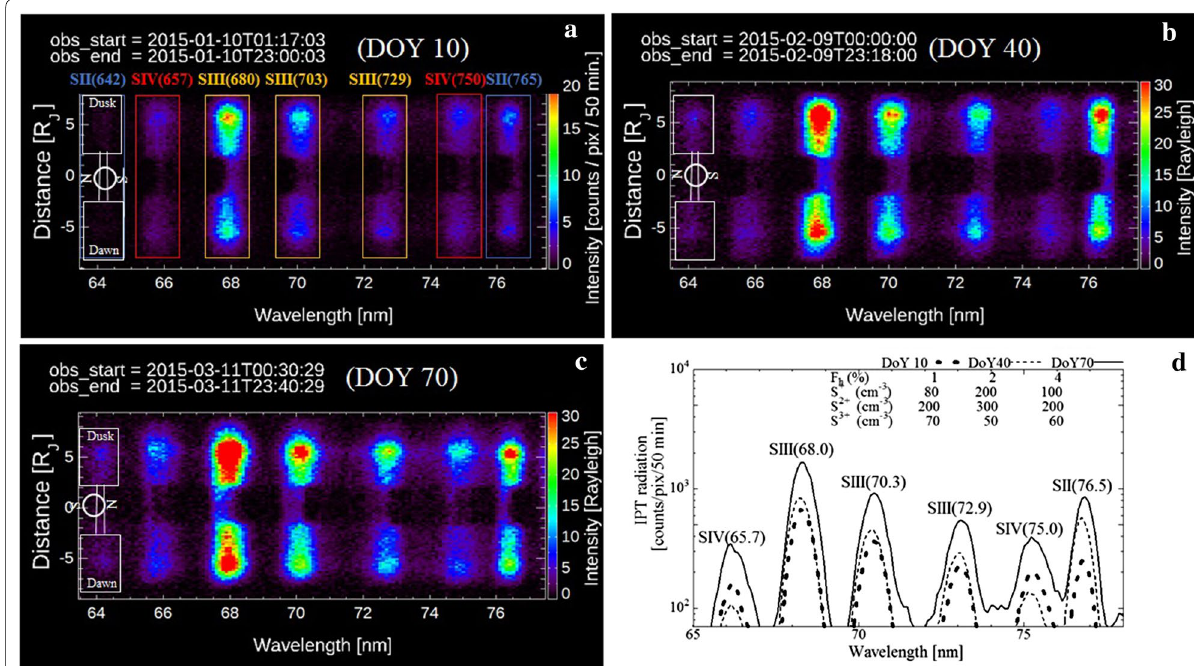
Fig. 4 a Spectrum in the short EUV range (65–78 nm) obtained on day-of-year (DOY) 10 in 2015 (before the eruption). Emissions from ionized sulfur occurred at S II (64.2 nm), S IV (65.7 nm), S III (68.0 nm), S III (70.3 nm), S III (72. 9 nm), S IV (75.0 nm), and S II (76.5 nm). The slit shape and directions (dawn–dusk and north–south) are displayed. b Spectrum on DOY 40 (rising phase of the eruption). c Spectrum on DOY 70 (peak of the eruption). Note that the north–south direction was overturned because of the maneuvering of the spacecraft. d Spectra in the shorter spectral range on DOY 10, 40, and 70. By applying spectral diagnosis, the hot electron fraction ( F h ) and sulfur ion densities were deduced (numbers in the figure). The hot electron fraction gradually increased between DOY 10 and 70, although the densities of S + and S 2 + decreased on DOY